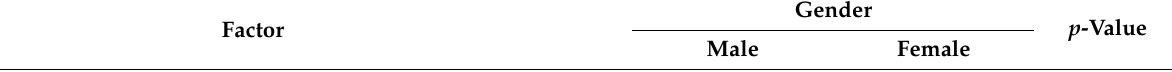
Gender Male Female